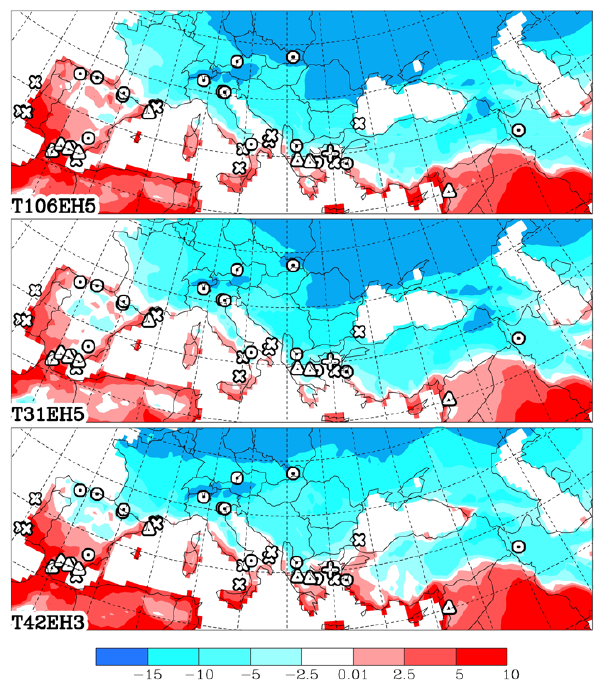
Fig. 8. 2m temperature of the coldest month. Contours at ± 0, 2.5, 5, 10, 15 ◦ C. Sites with observed summer-green tree growth during the LGM are indicated by markers. Circles: only cold-tolerant trees (continental), triangles: cool or warm-loving trees (continental), Xs: only cold-tolerant trees (marine), crosses: cool or warm-loving trees